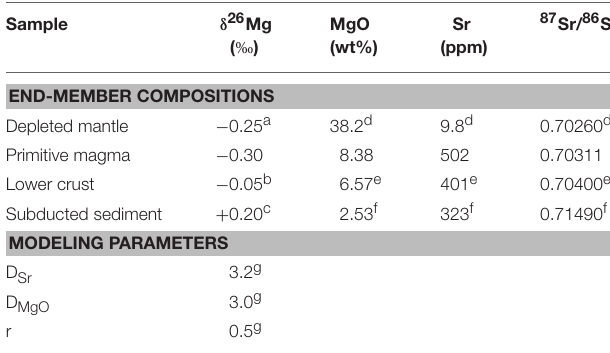
TABLE 2 | Modeling parameters and end-member